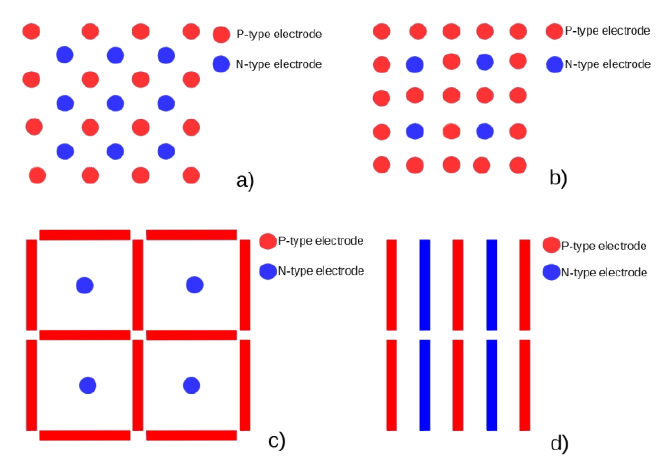
Figure 1. Baseline configuration of an a-Si:H detector. P-type electrodes are biased from the